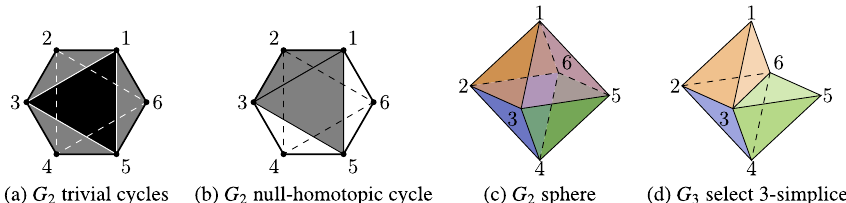
Fig. 5 A visual depiction of simplices and cycles present in G 2 . Left: Four trivial cycles filled by individual 2-simplices: [ 1 2 3 ] , [ 3 4 5 ] , [ 1 5 6 ] , and [ 1 3 5 ] . Center Left: A non-trivial, but null-homotopic cycle, 1, 2, 3, 5, 1 filled in by two 2-simplices [ 1 2 3 ] and [ 1 3 5 ] . Center Right: All eight 2-simplices represented as the faces of a regular octahedron. Right: The closed surface of G 2 is filled in by four 3-simplices [ 1 2 3 6 ] , [ 1 3 5 6 ] , [ 3 4 5 6 ] , [ 2 3 4 6